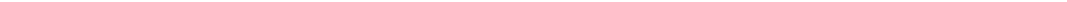
ectopic Notch3ICD expression cell line. These data indicate that Notch3 induces PTEN expression, which subsequently inhibits proliferation and migration/invasion, an effect that can be attenuated by silencing PTEN in vitro.